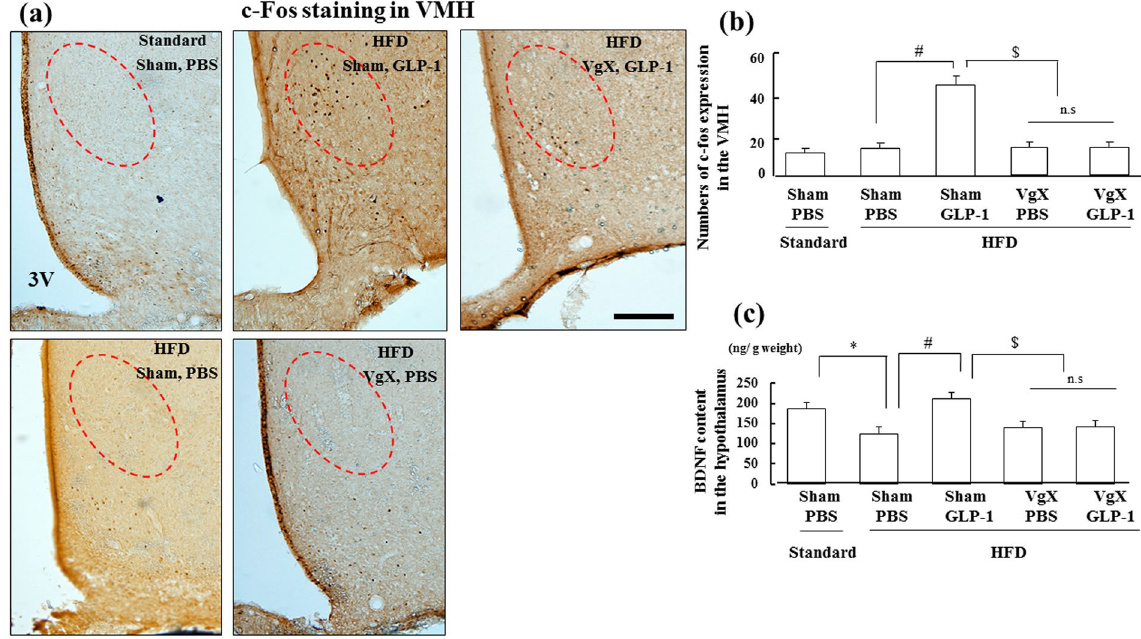
Figure 2. Chronic administration of GLP-1 (7–36) (5 nmol/kg BW) also increases c-fos expression and BDNF content in the hypothalamus through hepatic afferent nerves. ( a ) Representative c-fos staining of brain sections from each group. Red circle indicates the VMH area in the hypothalamus. ( b and c ) Quantification of c-fos expression in the VMH ( b ) and BDNF content in the hypothalamus ( c ) of each group (n = 6). * p < 0.05 vs. Standard (Sham, PBS) group, # p < 0.05 vs. HFD (Sham, PBS) group, $ p < 0.05 vs. HFD (Sham, GLP-1) group. Treatments: PBS; intraperitoneal administration of PBS, GLP-1; intraperitoneal administration of GLP-1 (7– 36), Standard; fed with standard diet, HFD; fed with high-fat diet, Sham; sham operation, VgX; hepatic afferent vagotomy. 3 V; third ventricle. Scale bar = 100 μ